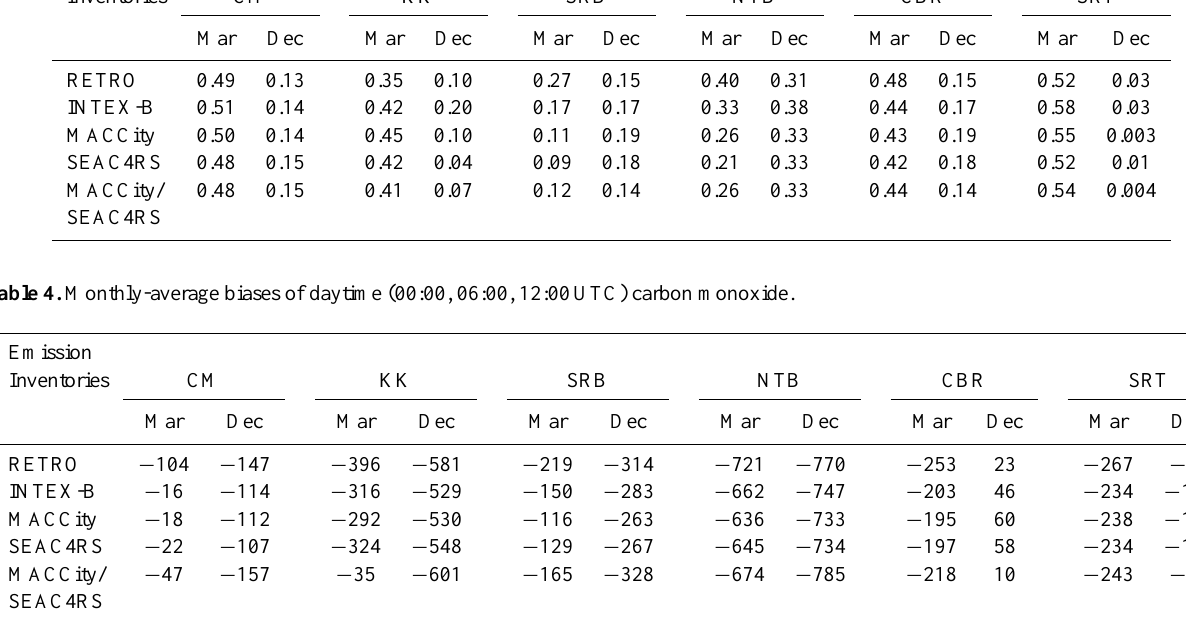
Table 3. Monthly-average correlation coefficients ( r ) of daytime (00:00, 06:00, 12:00UTC) CO. Emission